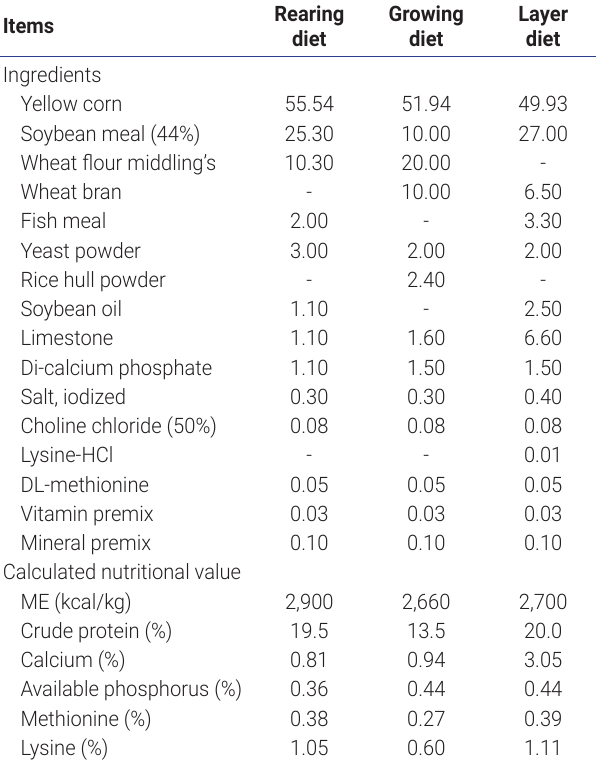
Table 1. Diet ingredients and composition in the rearing period (0 to 8 weeks of age), growing period (8 to 18 weeks of age) and laying period (after 18 weeks of